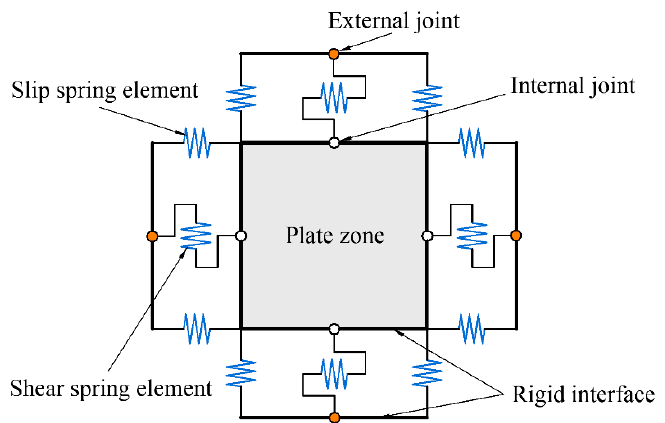
Figure 15. Analytical model of the joint specimens.